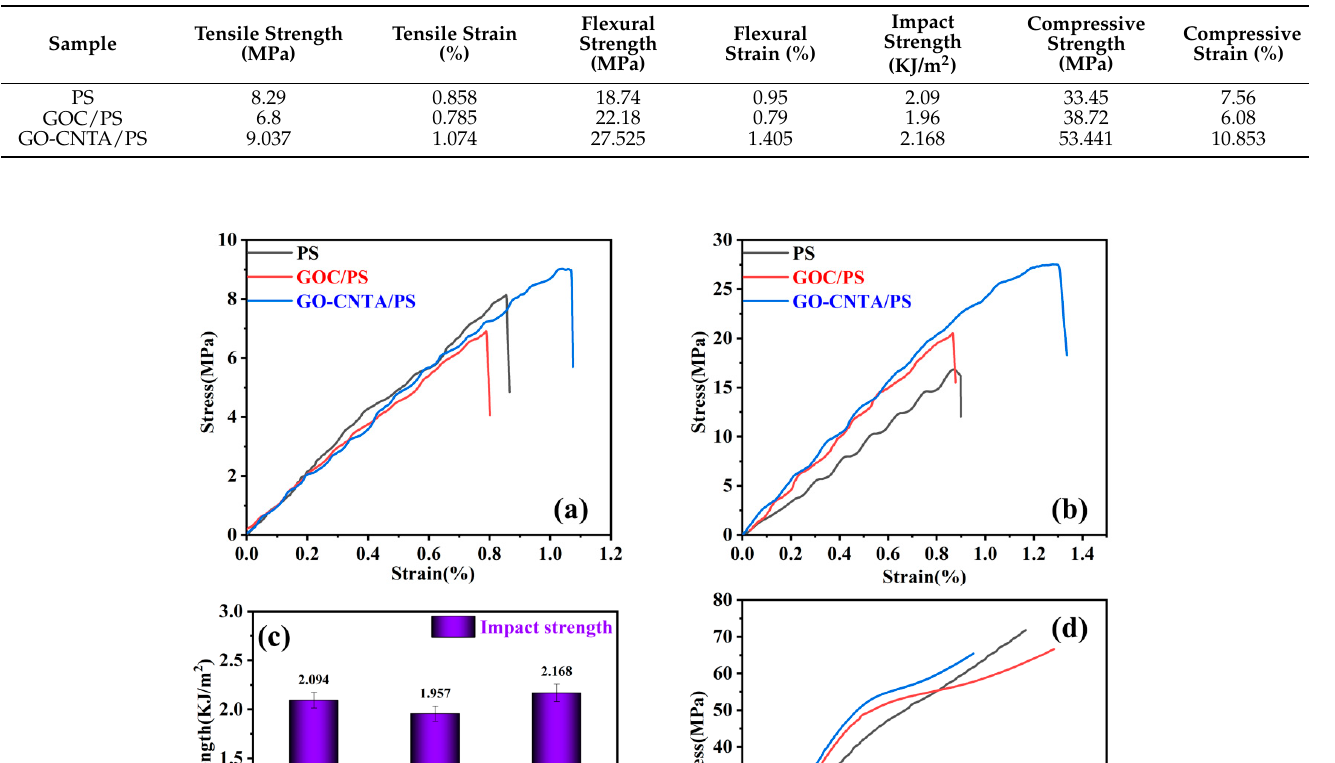
Figure 10. Electrical and thermal conductivity of neat PS, GOCA/PS and GO-CNTA/PS. The thermal properties of the nanocomposites were also analyzed. Figure 11 shows the differential scanning calorimetry curves for the different samples. It can be seen that the glass transition temperature of GO-CNTA/PS was the highest, which was due to the physical crosslinking effect in the complete GO-CNT network in the nanocomposite. However, the 3D network structure for GO-CNT was incomplete and thus not able to improve the glass transition temperature of the nanocomposites. In addition, the crystal- lization tendency of polystyrene was enhanced by the induction of GO, and the crystalli- zation temperature of GOCA/PS and GO-CNTA/PS composites was lower than that of pure polystyrene.